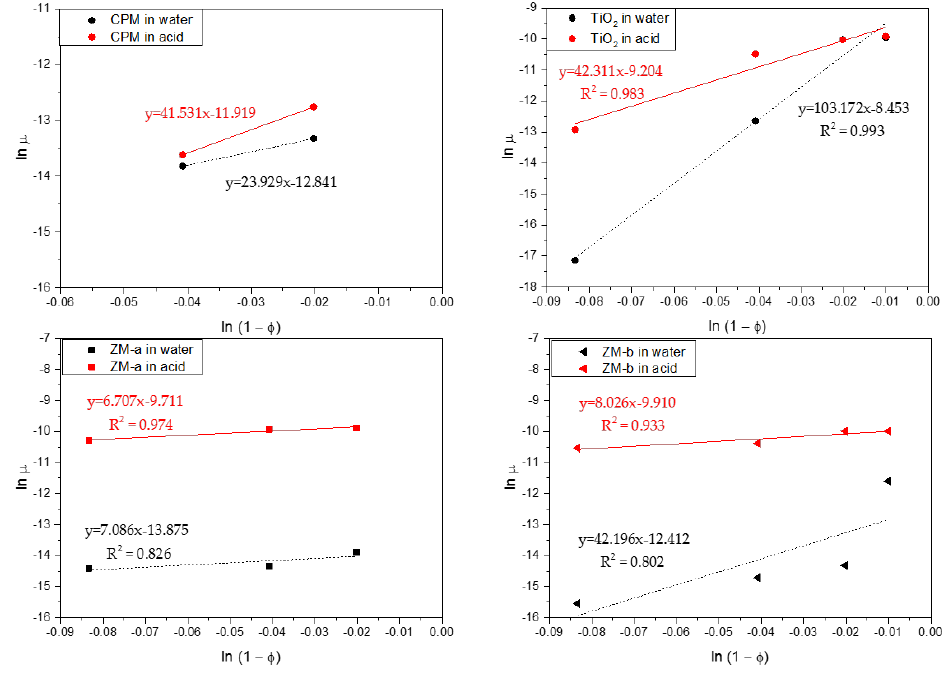
Figure 10. log–log linearised settling rates versus porosity (1 − Φ ) for caesium phosphomolybdate (CPM), Titanium dioxide (TiO 2 ) and Zirconium molybdate (ZM-a and ZM-b) in both water and 2 M HNO 3 environments. Dashed lines indicate power-law fits.